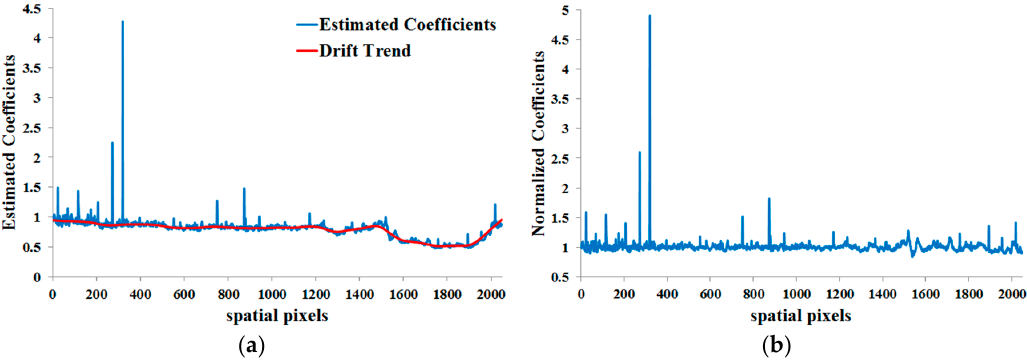
Figure 14. ( a ) Estimated coefficients of band 60 and the corresponding drift trend; ( b ) Normalized Figure 14. ( a )Estimatedcoefficientsofband60andthecorrespondingdrifttrend; ( b )Normalizedcoefficients. coefficients. Remote Sens. 2018 , 10 , 79